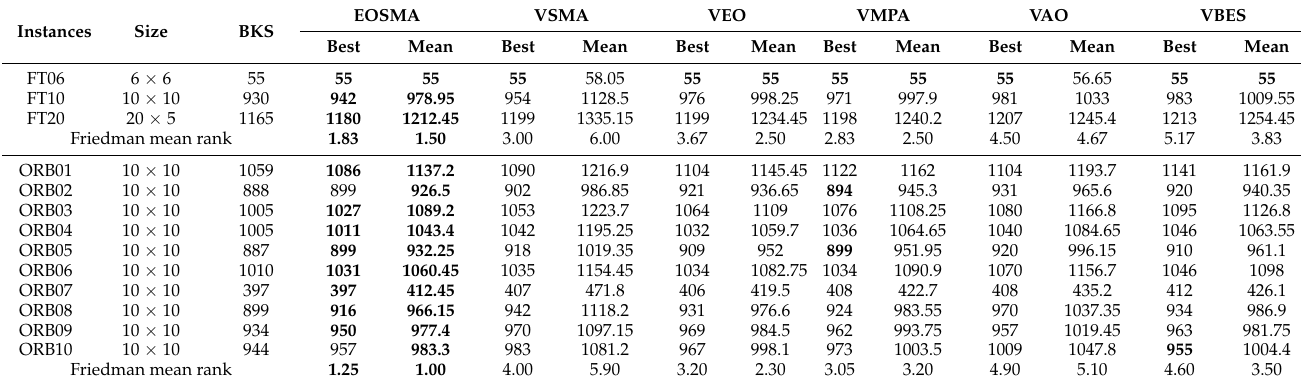
Table 5. Comparison of solution results of algorithms on FT and ORB.